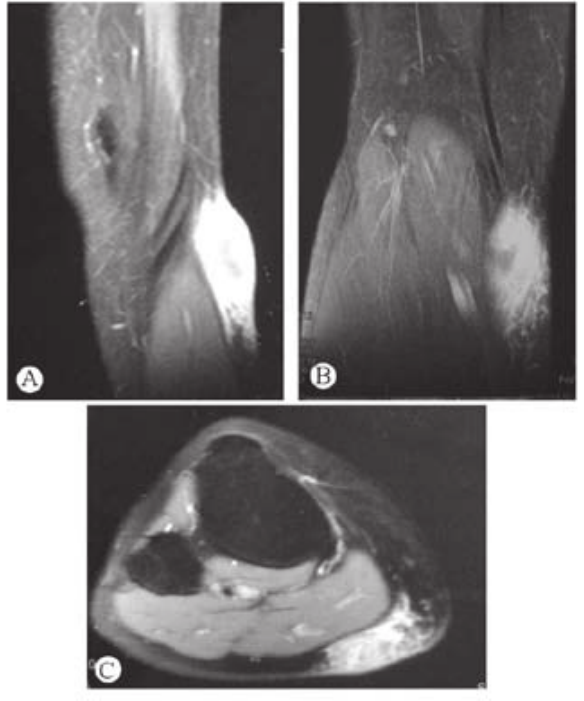
Figure 1 – Fat suppressed contrast-enhanced T1-weighted magnetic resonance imaging of the posterior leg. Expansive subcutaneous mass adjacent to medial